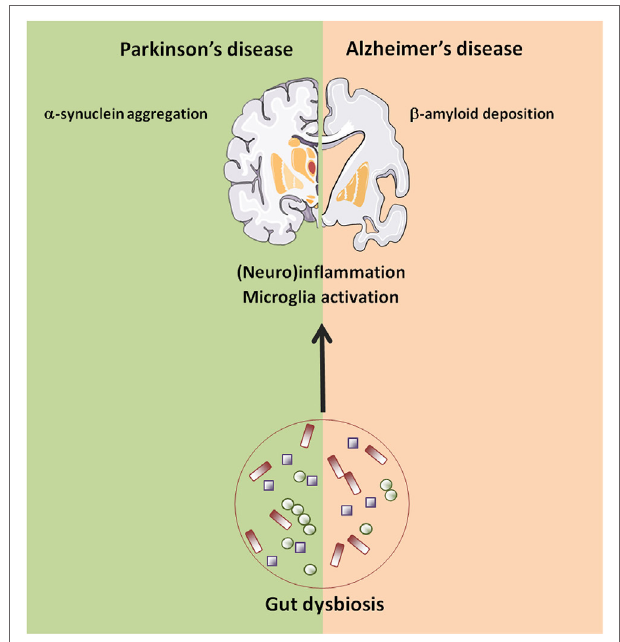
FiGURe 2 | Age-related changes in gut–brain axis possibly involved in neurodegeneration. Abbreviations: AD, Alzheimer’s disease; PD, Parkinson’s